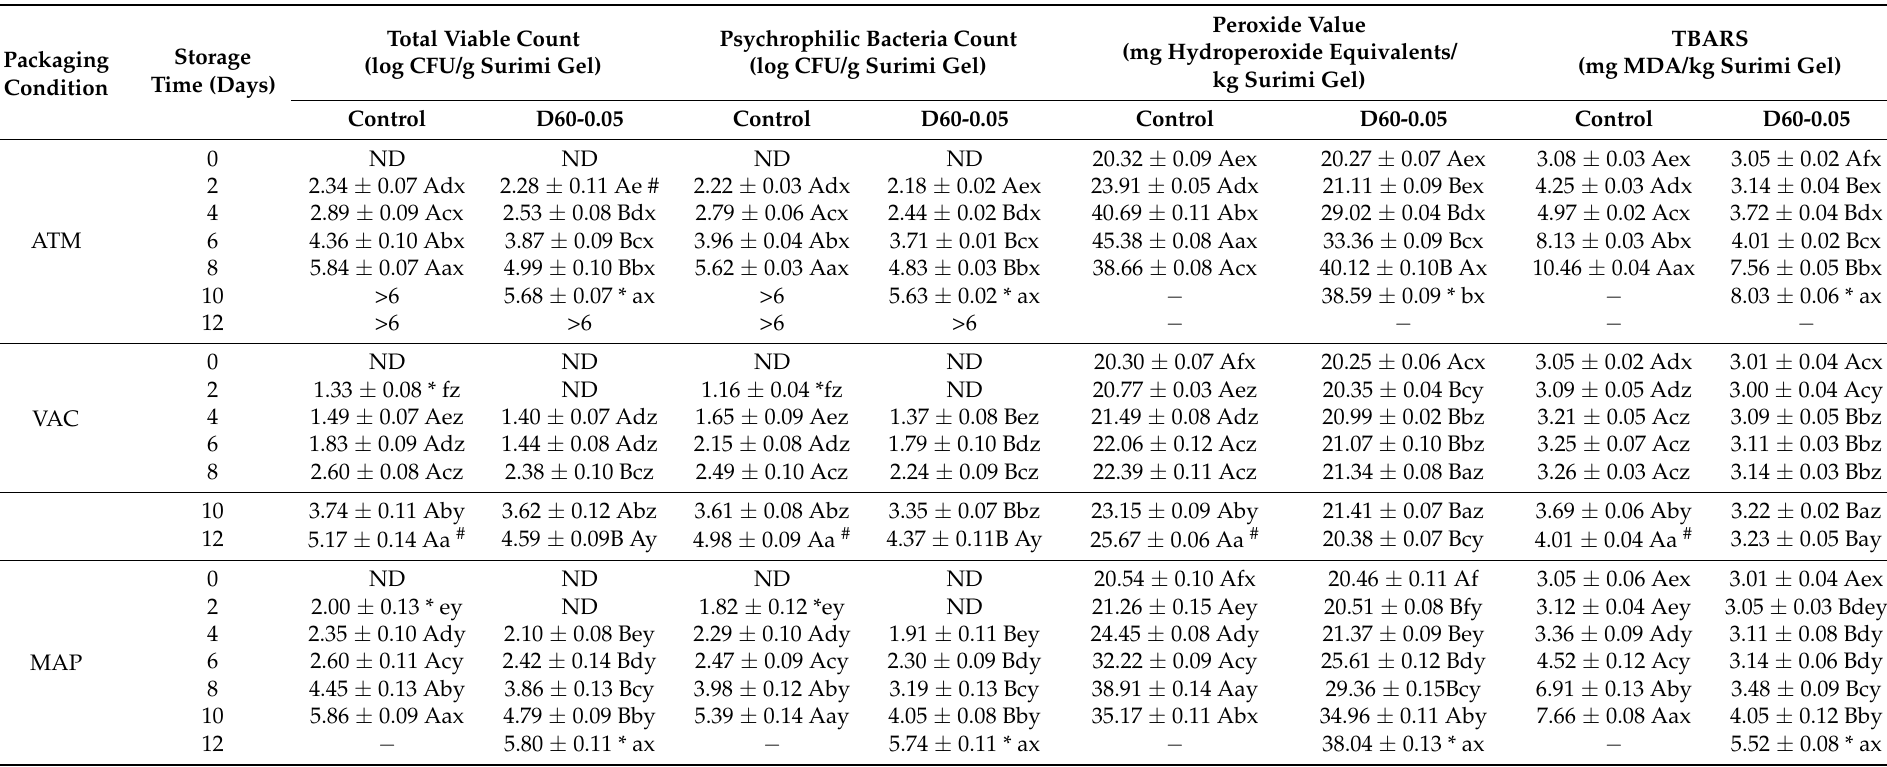
Table 5. Total viable count, psychrophilic bacteria count, peroxide value and TBARS of surimi gel without and with 0.05% DCE-60 added under different packaging conditions during refrigerated